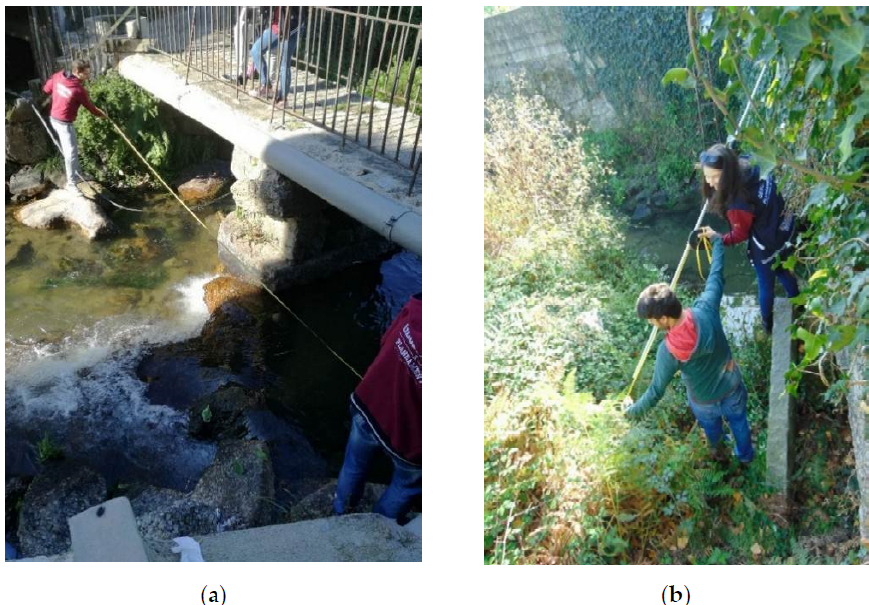
Figure 8. Channel surveying, associated with Section L: ( a ) width measurements; ( b ) height